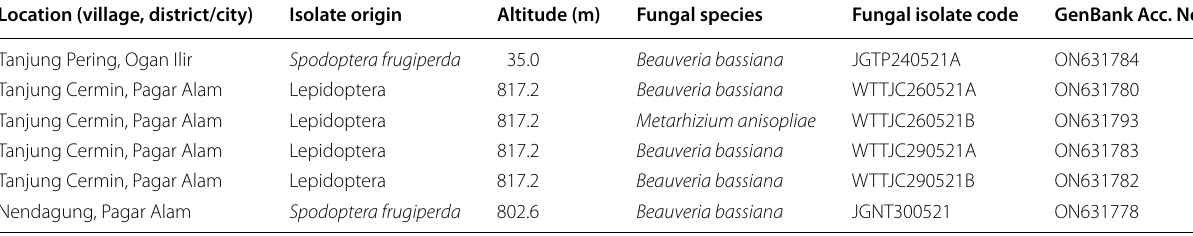
Table 1 Origin of isolates of endophytic entomopathogenic fungi from South Sumatra, Indonesia Location (village,